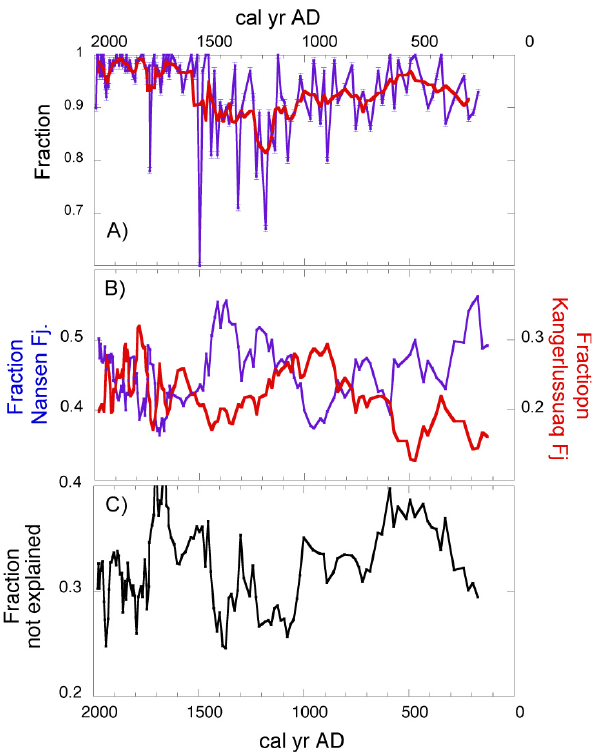
Fig. 7. (A) Changes in the fraction of sediment with a similar min- eralogy to the uppermost 5 samples ( last 100yr) at site 2322 (blue) (Fig. 1) and 5 point running mean (red). (B) Estimated fractions of sediment to site 2322 from the Nansen Fjord (blue) or Kangerlus- suaq Fjord (red) based on mineralogy. (C) Changes in the average fraction of sediment not attributable to either source (see Fig.